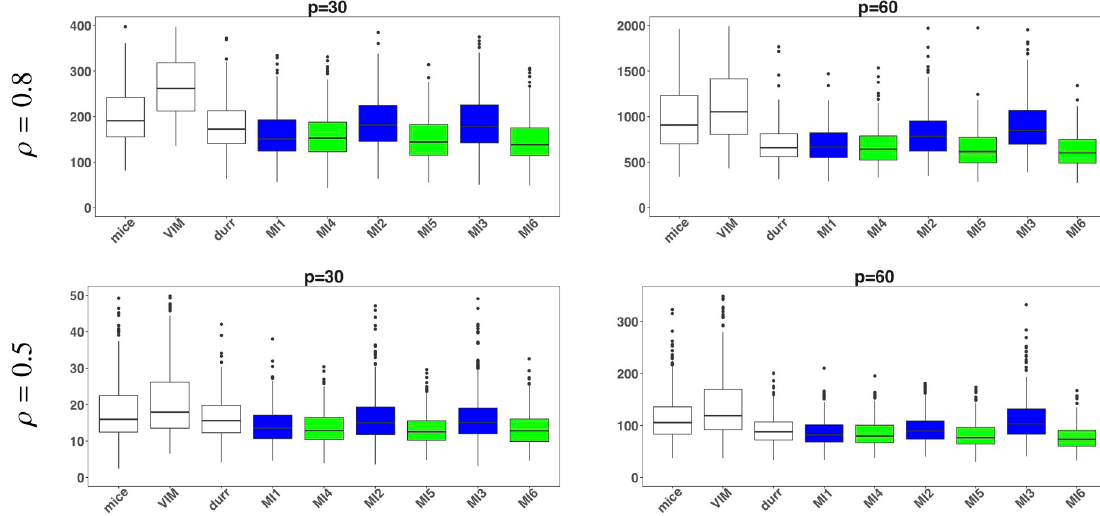
Fig 2. Simulation study: Box plots of MSE( ^ b ) for 30% missing values. White boxes represent the threshold MI methods i.e., mice and VIM and durr . Blue and green boxes represent the results based on imputed data using the MLE fit and ridge fit to the selected imputation model respectively.